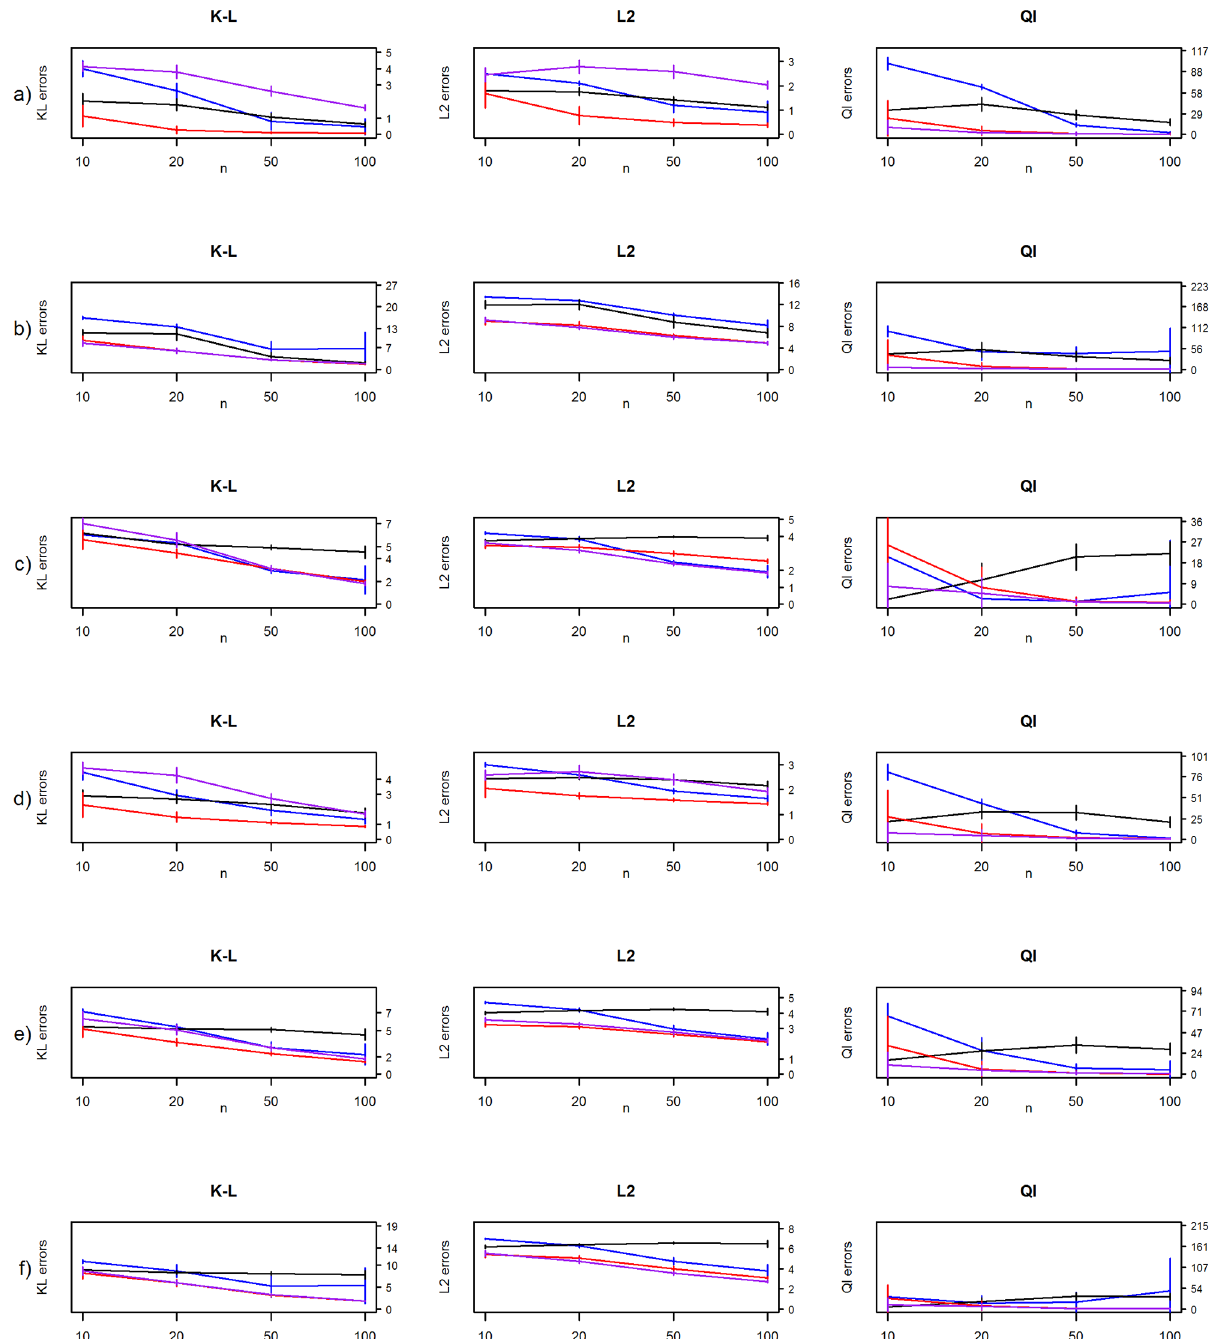
Fig 5. Frequentist risk estimates from the simulation studies. Kullback-Leibler (K-L), L2-loss (L2) and quadratic losses (Ql) for MAP-estimate with diminished condition number combined with decision-rule (blue line), hierarchical Bayes model by Bouriga and Féron (purple line), the Ledoit and Wolf estimate (red line) and graphical lasso algorithm (black line) for (a) diagonal, (b) AR(1), (c) AR(2), (d) sparse, (e) moderate and (f) dense precision matrices.